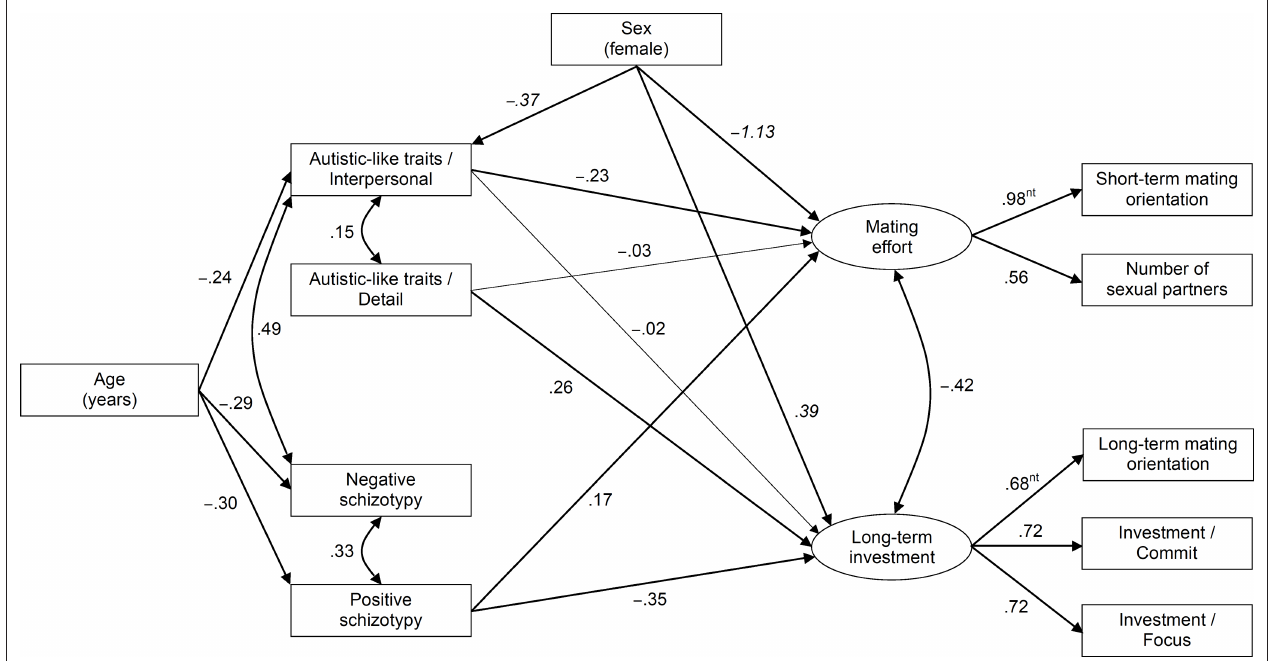
Figure 2 | standardized path diagram of the selected model. For clarity of presentation, variances, disturbances, and measurement errors are omitted. The effects of sex (italicized) are reported as standardized differences between